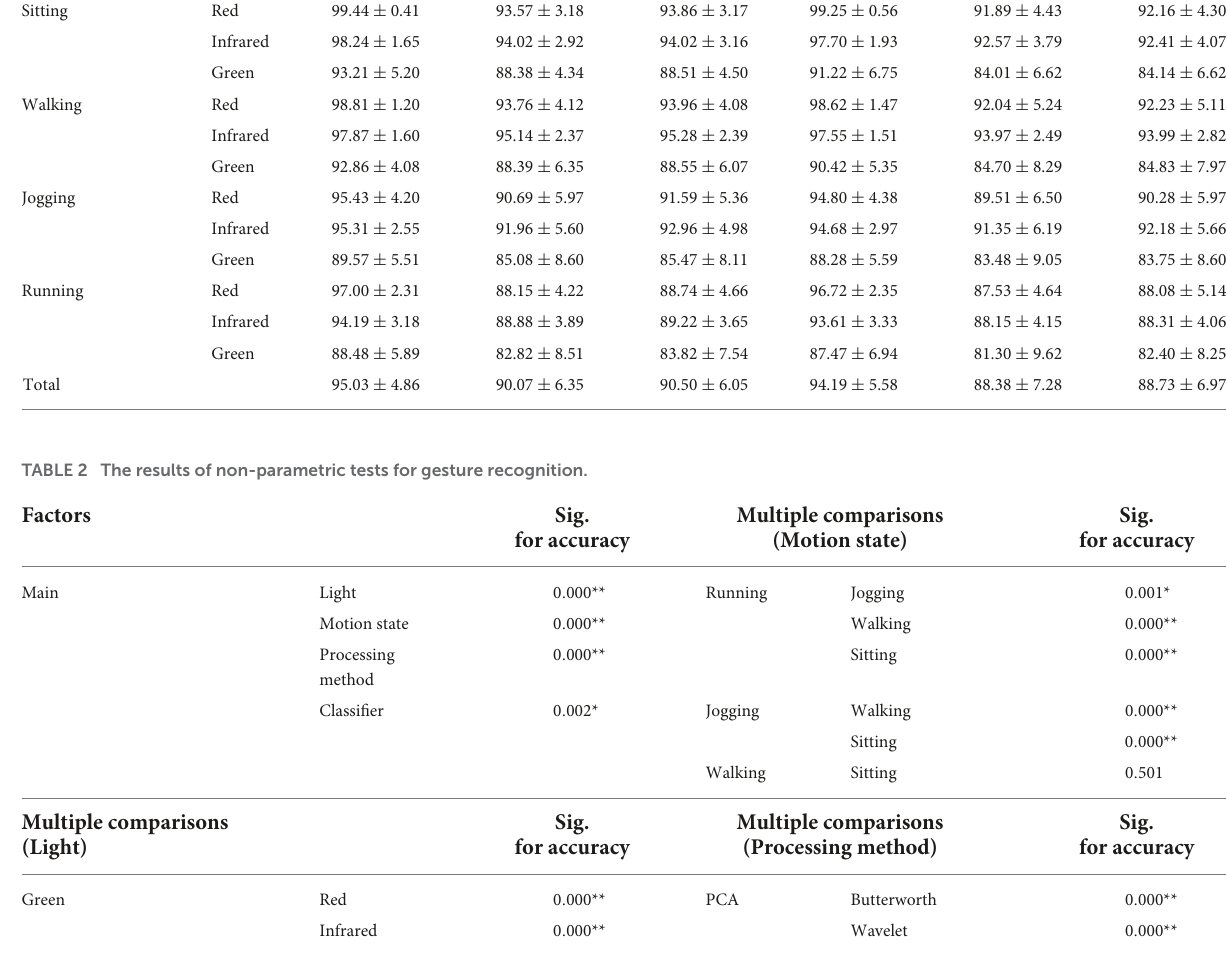
TABLE 1 Hand gesture recognition accuracies (%) of 14 gestures.